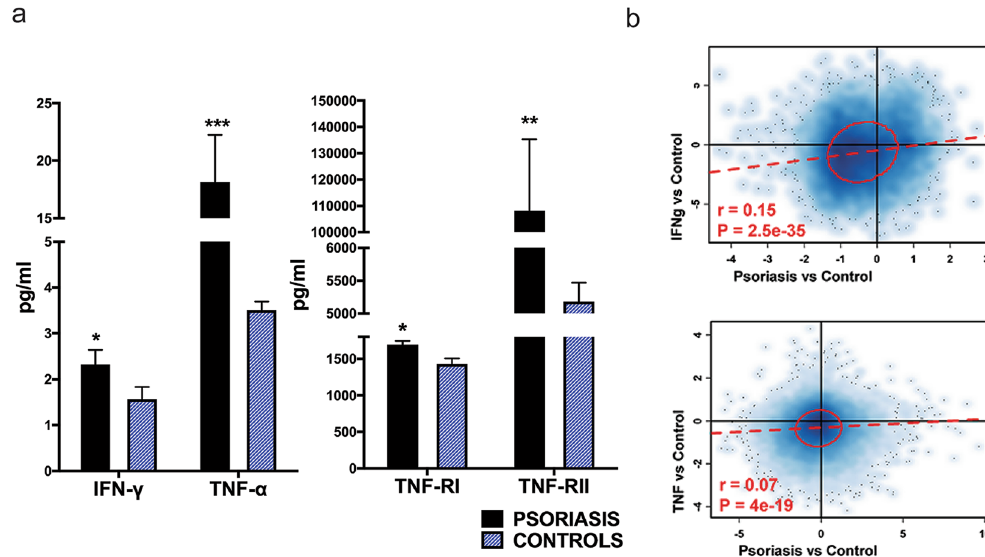
Figure 3. Serum IFN- γ and TNF is increased in psoriasis compared to healthy controls. ( a ) Serum IFN- γ was approximately 2.4-fold higher in patients with psoriasis compared to healthy controls, whereas serum TNF- α was about 31-fold higher (n = 112 patients, n = 54 controls, * p < 0.05, *** p < 0.001, Student’s t-tests). Serum levels of TNFRI and TNFR-II were 1.2-fold and 21-fold higher respectively in patients with psoriasis compared to controls (n = 120 patients, n = 29 controls, * p < 0.05, ** p < 0.01, Student’s t-tests). ( b ) Global gene expression from PBMCs from psoriasis patients vs. control (n = 5 psoriasis vs. n = 5 controls) compared against data obtained from TNF and IFN- γ stimulated vs. unstimulated PBMCs, demonstrates positive correlation with IFN- γ and TNF- α responses (p = 2.5 × 10 − 35 , p = 4 × 10 − 19 respectively, Spearman rank correlation). Data are shown as mean ± SEM with 95%